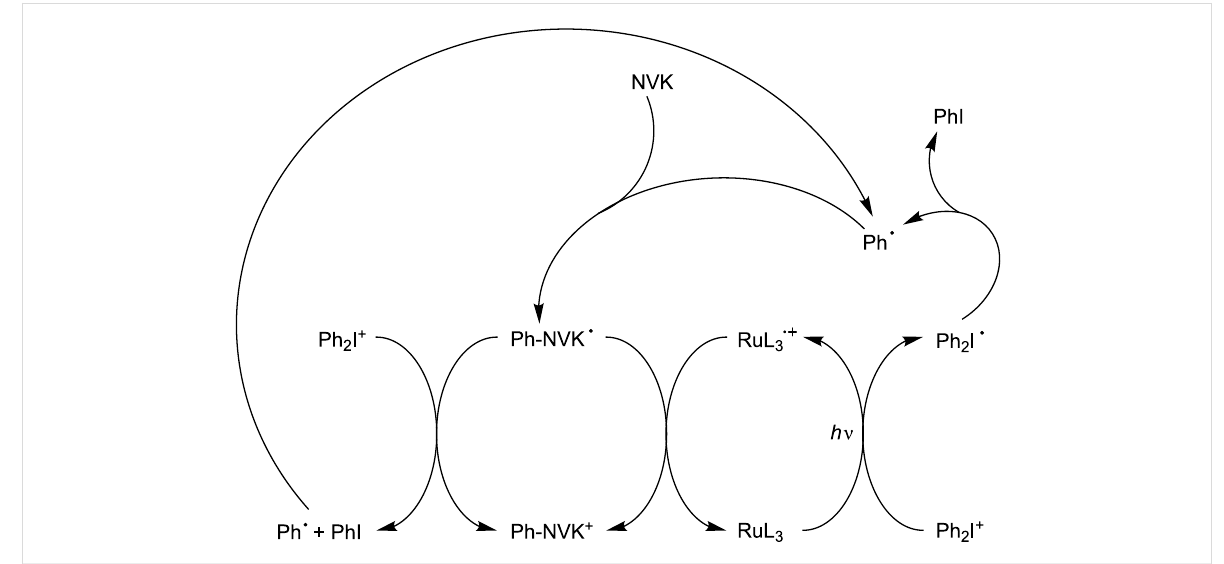
Scheme 8: Reaction mechanisms for the Ru(ligand) 32+ /Ph 2 I + /NVK system upon visible lights.